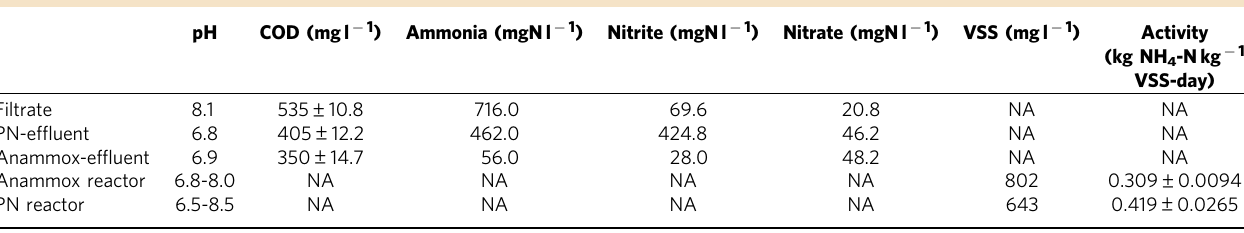
Table 2 | Process performance data from the two-stage PNA bioreactor at steady-state